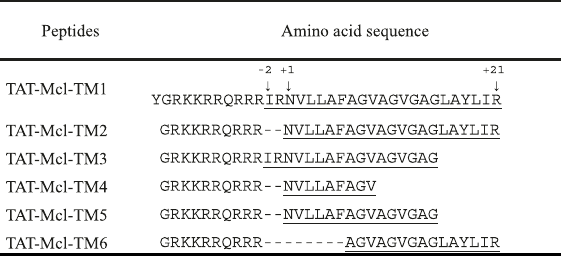
Peptide sequences underlined are derived from the Mcl-1 transmembrane